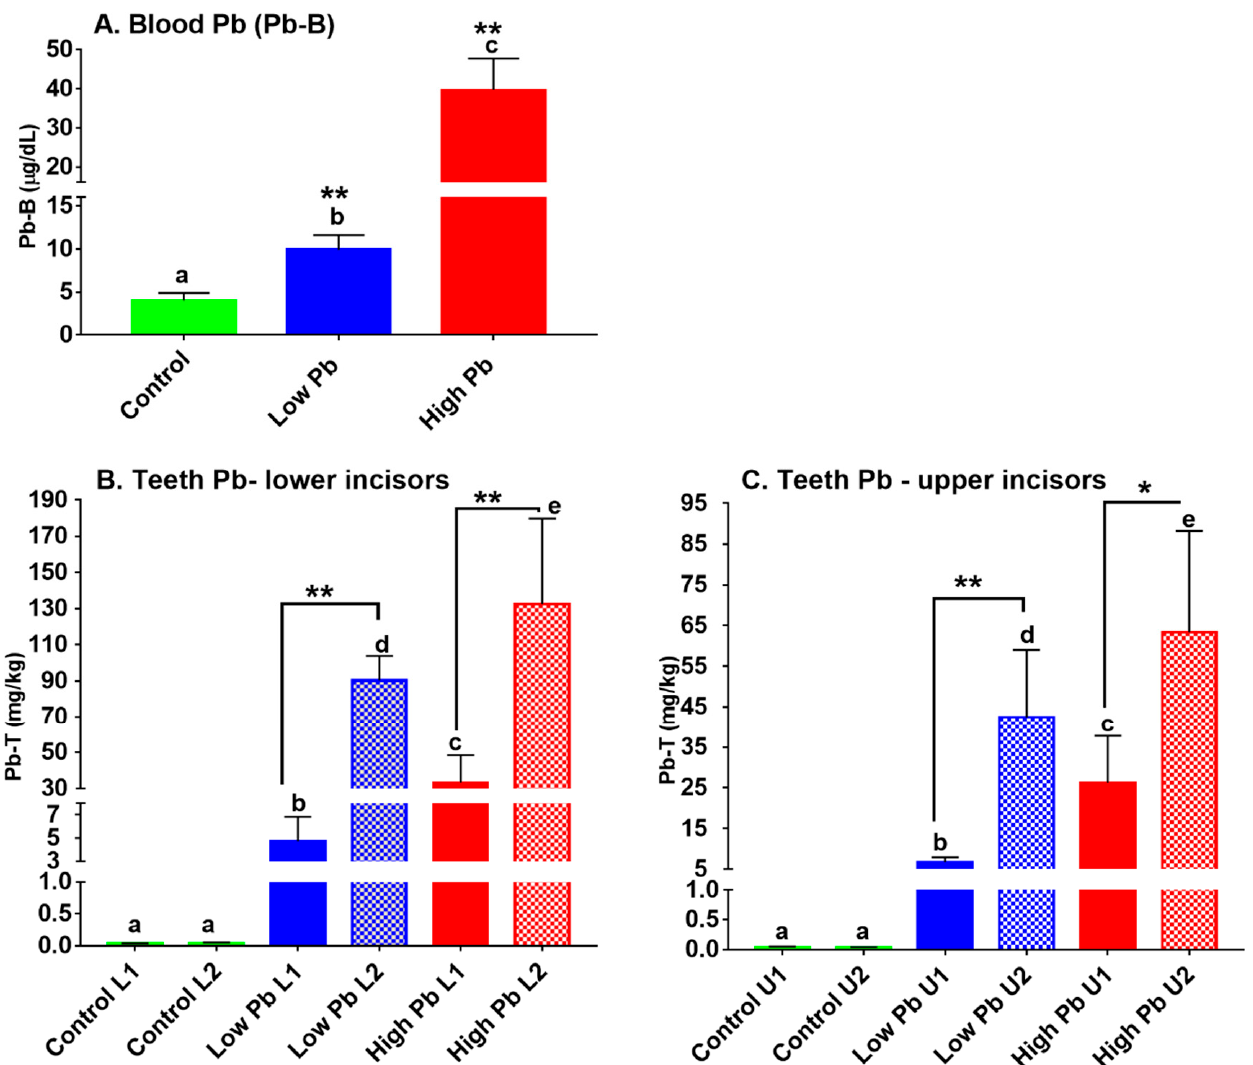
Figure 3. Mean ± SD of Pb-B and Pb-T of laboratory Pb exposed Sprague Dawley rats. ( A ) Pb-B in control ( n = 6), low Pb (100 mg/L Pb; n = 6), and high Pb (1000 mg/L Pb; n = 6); ( B ) Pb-T in the lower incisor divisions (L1 and L2) and; ( C ) Pb-T in the upper incisor divisions (U1 and U2). The lower-case letters a, b, c, d, and e represent significant differences among the groups using Tukey’s multiple comparison test ( p < 0.05). For the Pb-B, ** at p < 0.01 represents a significant difference between the control and exposure groups, and for the Pb-T, * at p < 0.05 and ** at p < 0.01 represent a significant difference between the crown and root of incisor teeth in each group Turkey’s test.